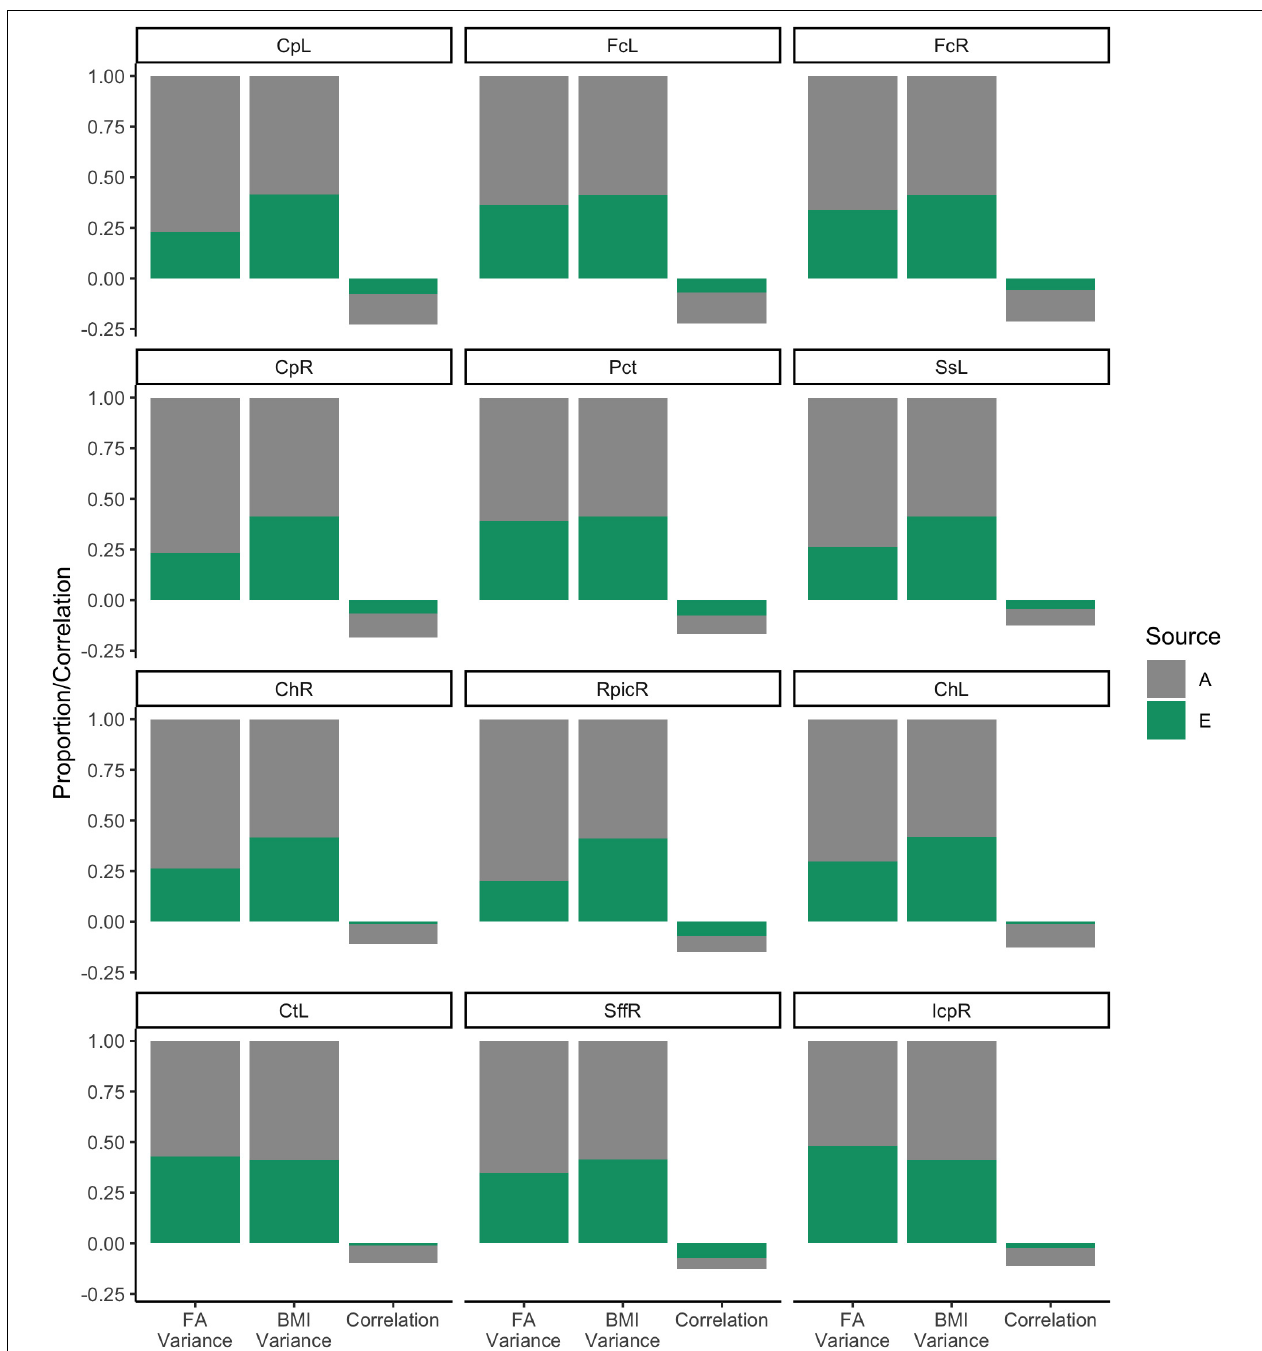
FIGURE 6 | Variance and correlation components for body mass index and white matter fractional anisotropy.